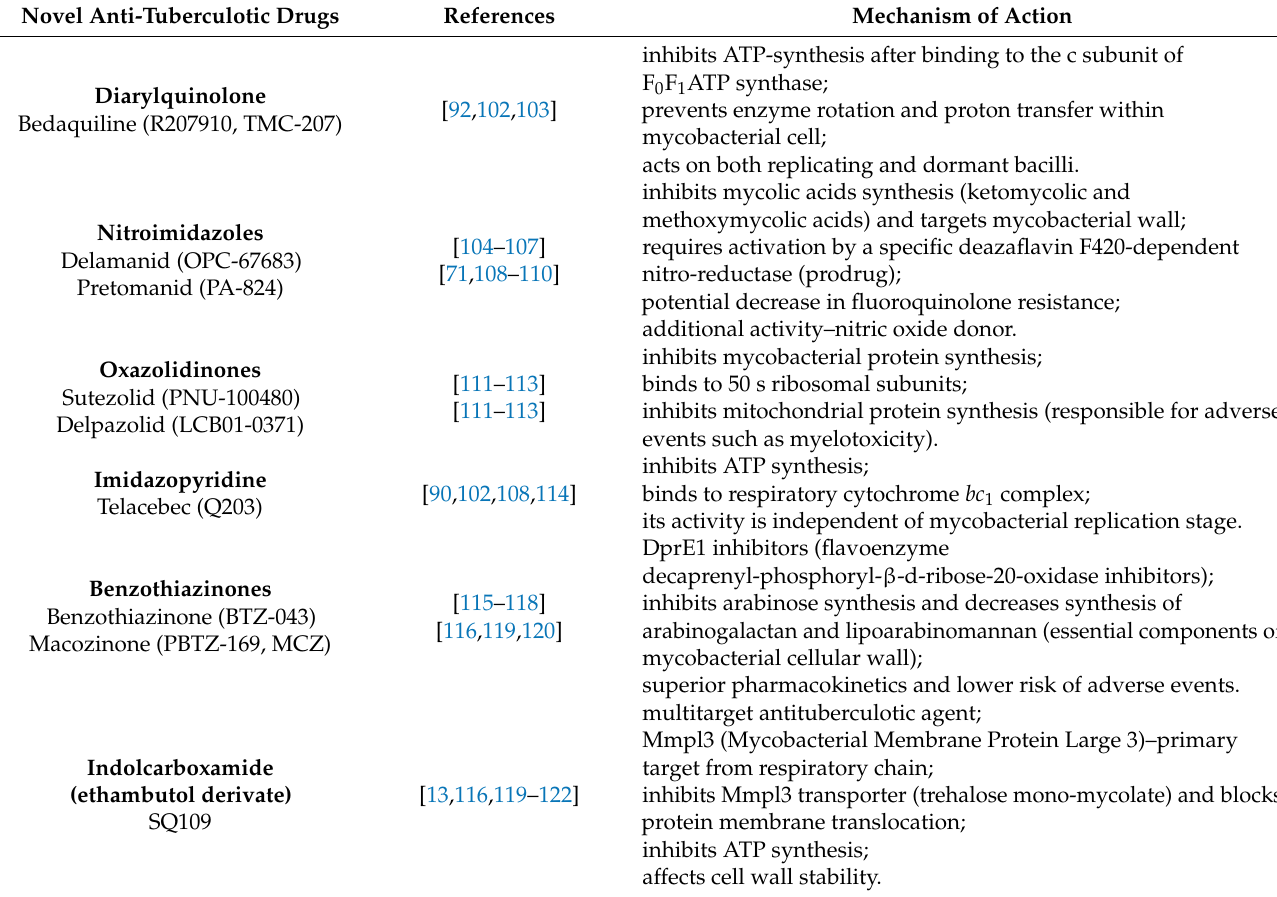
Table 1. Novel antituberculotic drugs and their mechanisms of action. Novel Anti-Tuberculotic